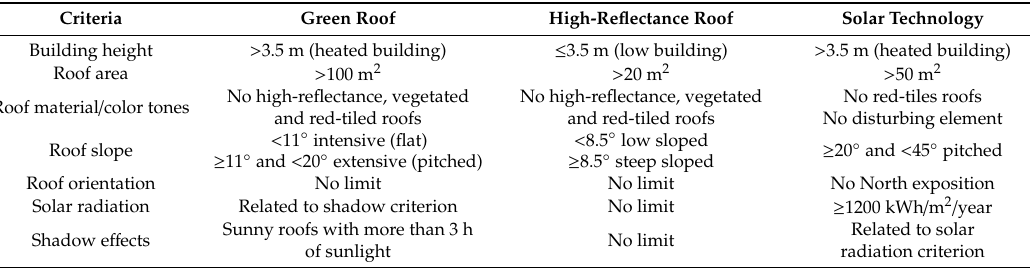
Table 2. Criteria to assess rooftop renovation